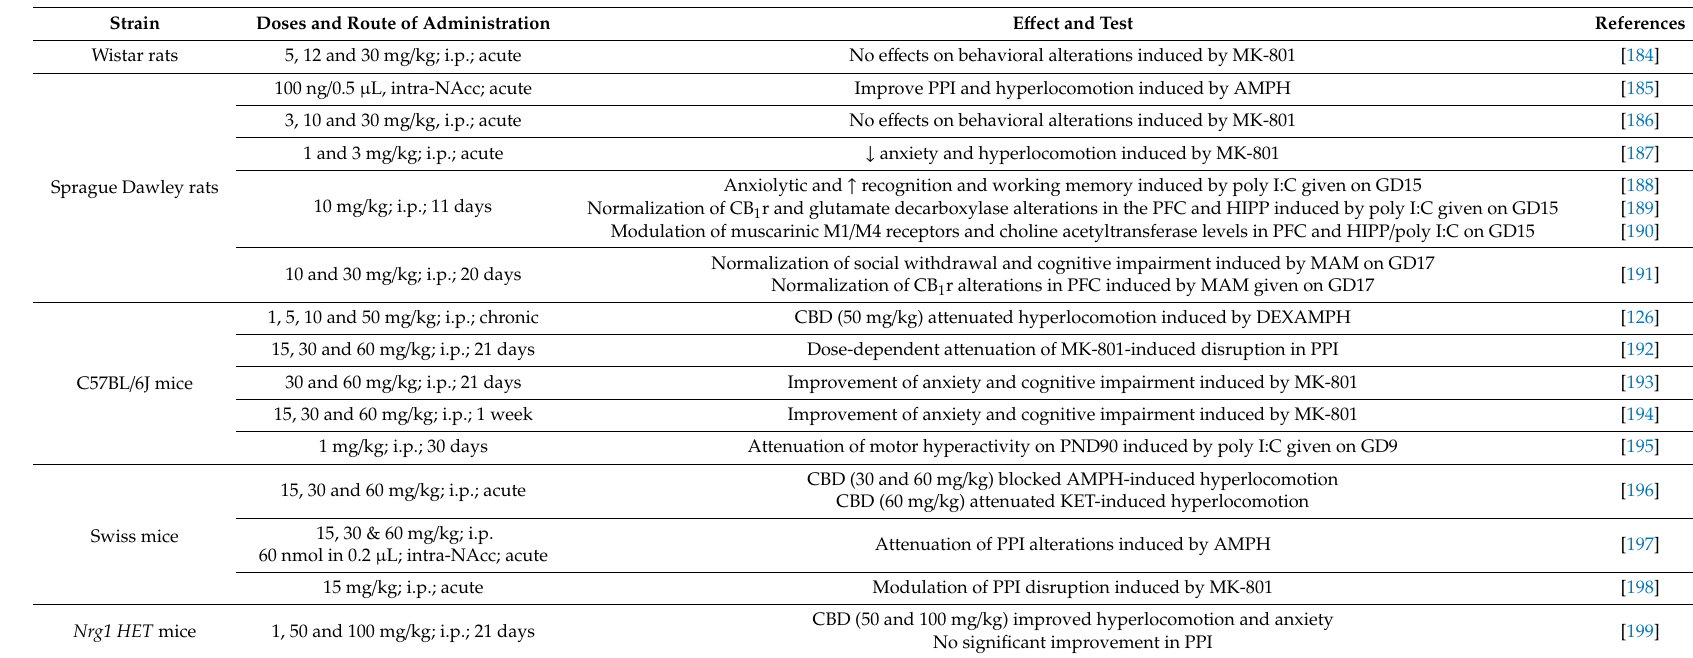
Table 4. CBD studies on animal models of